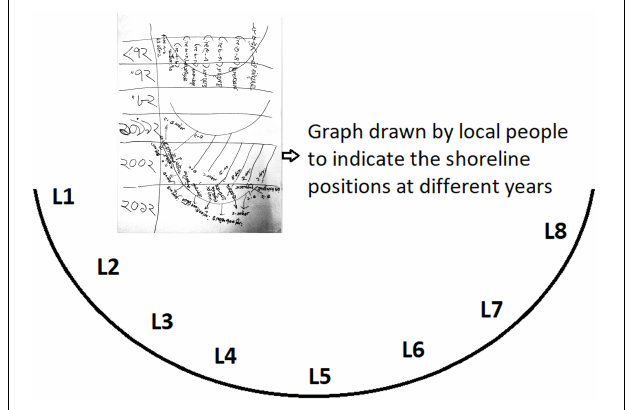
FIGURE 6 | Comparative position of local places along the shoreline according to the local